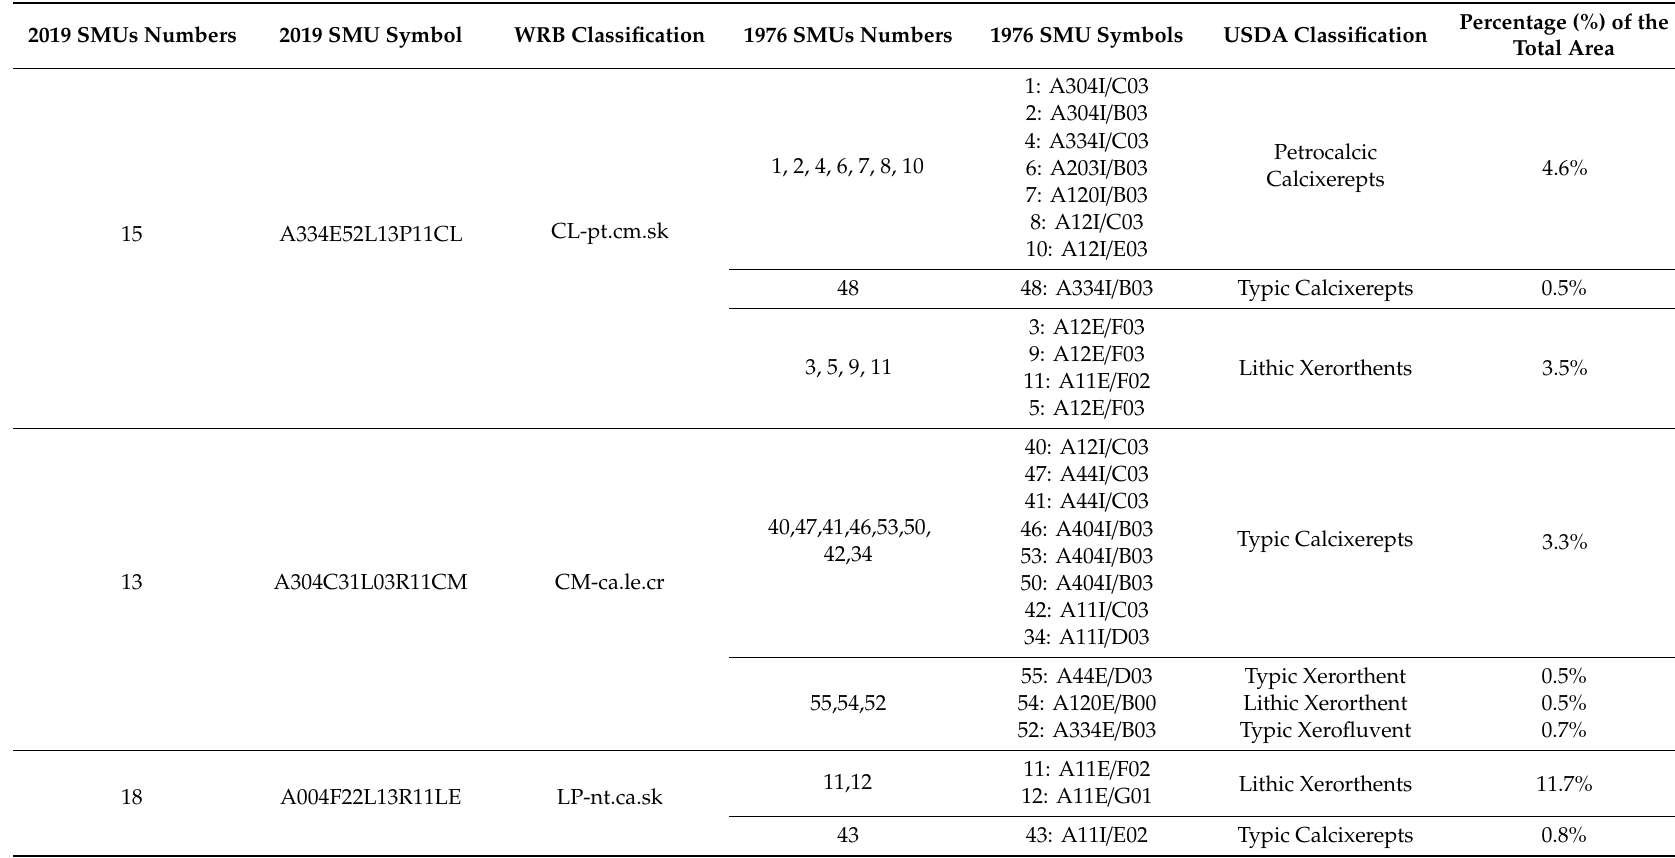
Table A10. Correlation table of the cartographic symbols and soil classification of the two mapping